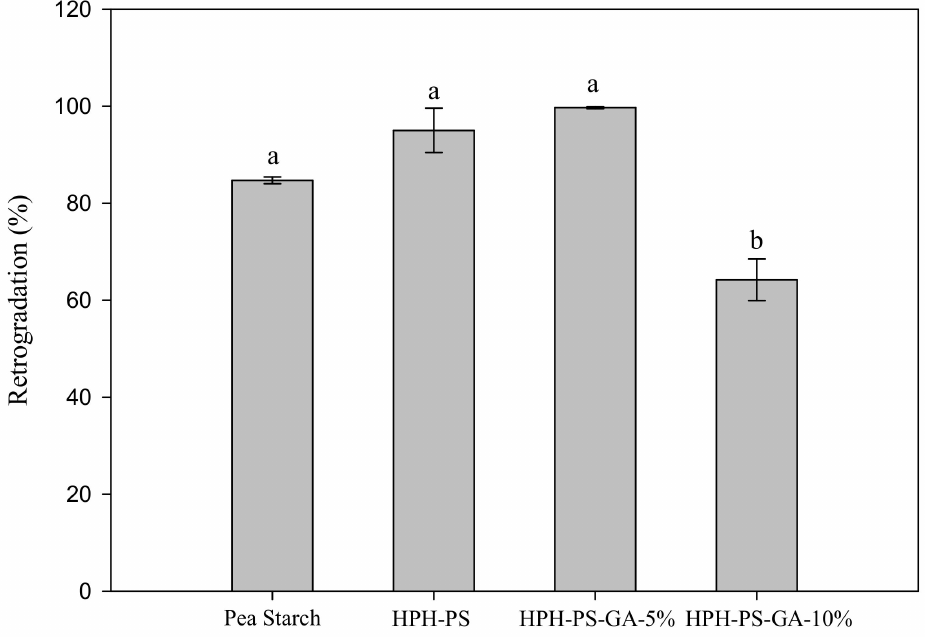
Figure 1. Retrogradation percentage of native and modified pea starch. HPH-PS: high- pressure homogenization-treated pea starch; HPH-PA-GA-5% and HPH-PA-GA-10%: high-pressure homogenization-treated pea starch with 5% or 10% gallic acid. The letters a and b indicate statistically significant difference at p < 0.05 between